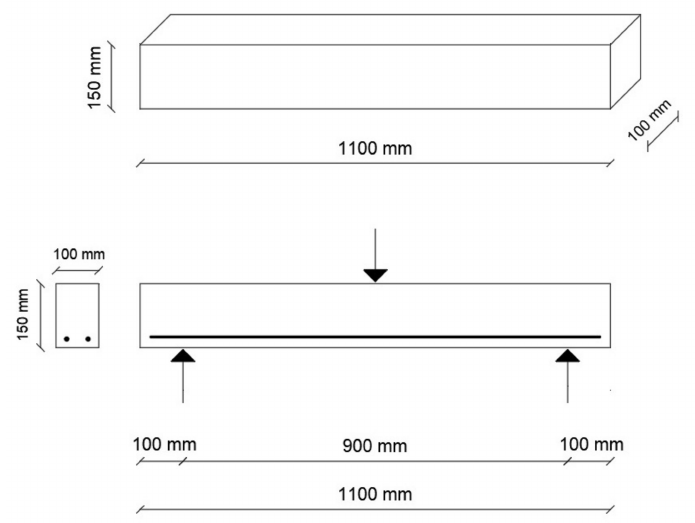
Figure 4. Beam dimensions and reinforcement layout.